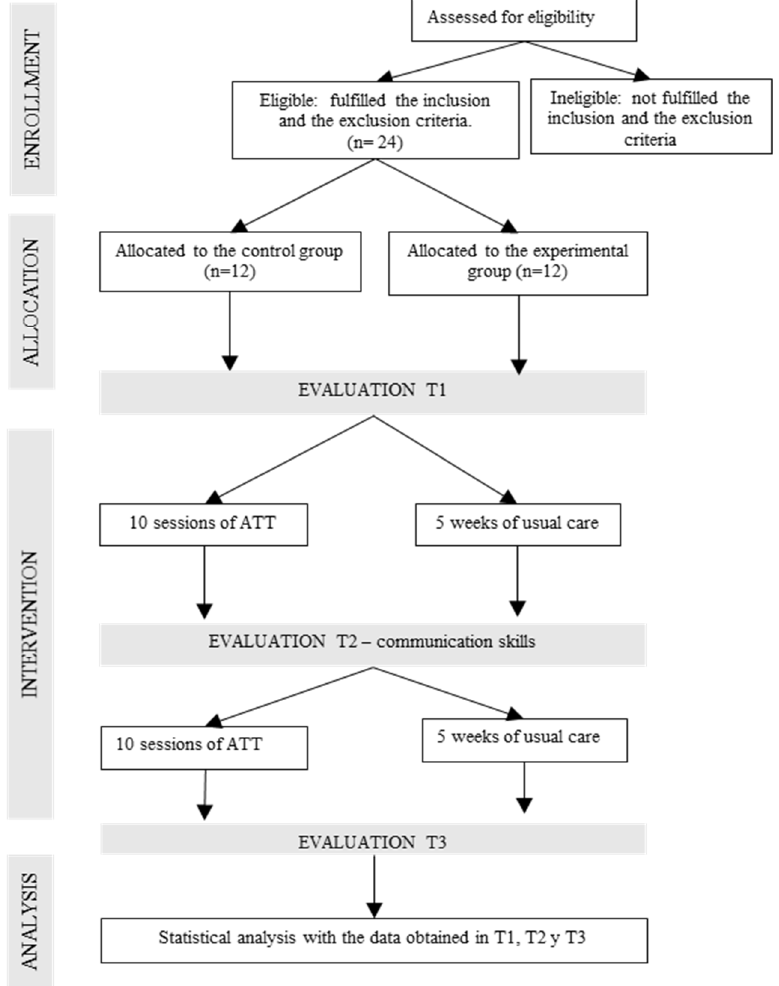
Figure 1. Protocol timeline implemented in the study.